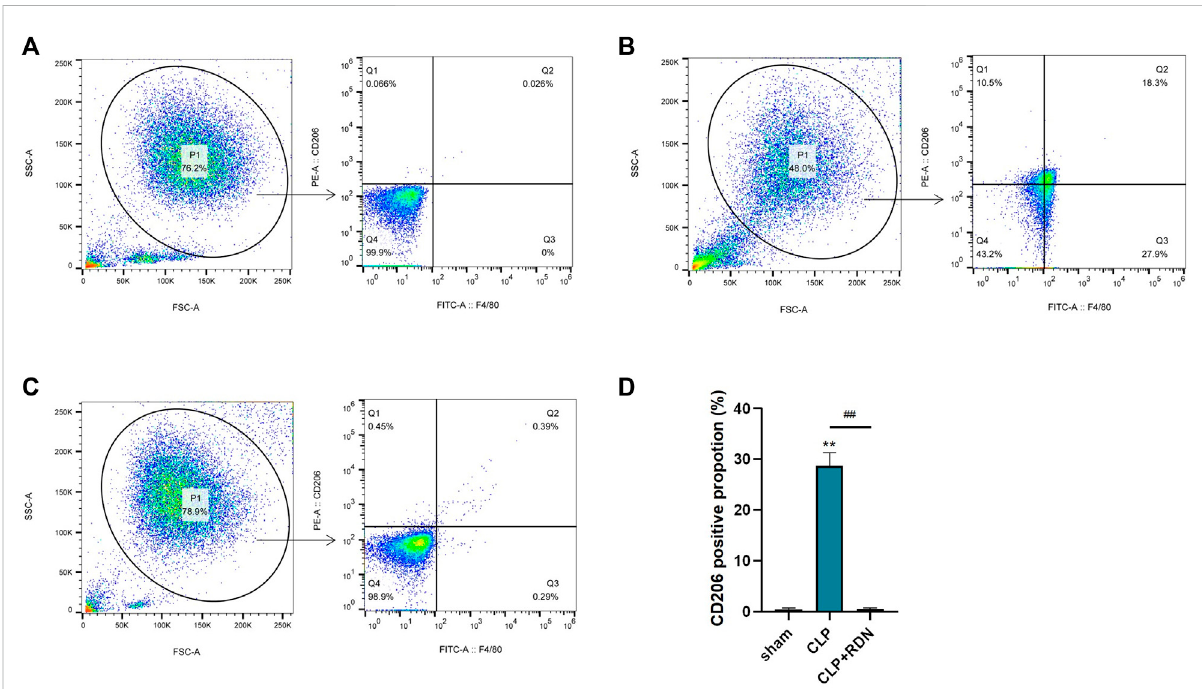
FIGURE 9 The impact of Reduning on the polarization of AMs. The expression of CD206 on alveolar macrophages in the sham group (A) , CLP group (B) , and CLP+100 mg/kg RDN group (C) was detected by fl ow cytometry and statistically plotted (D) . Data are presented as mean ± SD (n = 3 per group) ofthe representativedata from three independent experiments; **** p < 0.001 and #### p < 0.001.The asterisk (*)represents statistically signi fi cant difference between the indicated group and the Con